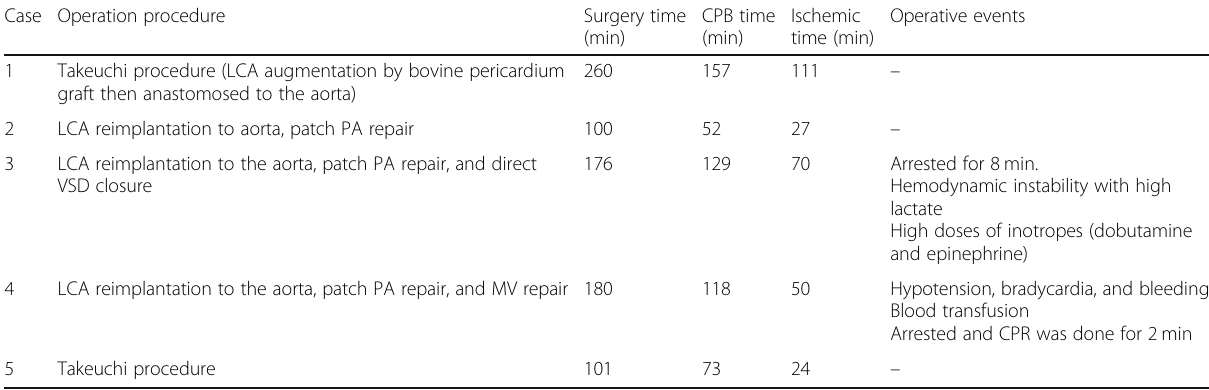
Table 2 Operative details of patients who underwent ALCAPA repair Case Operation